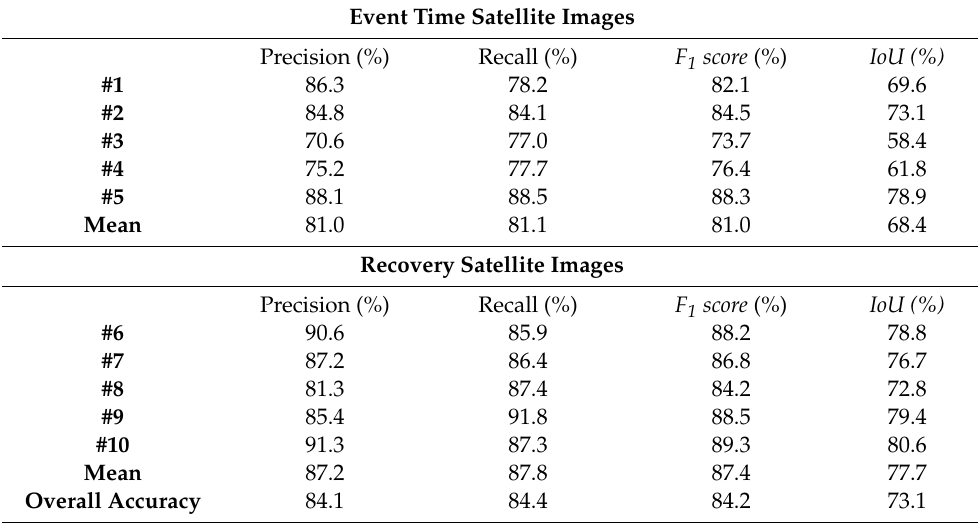
Table 3. Numerical results of the proposed post-disaster building database update for event and recovery